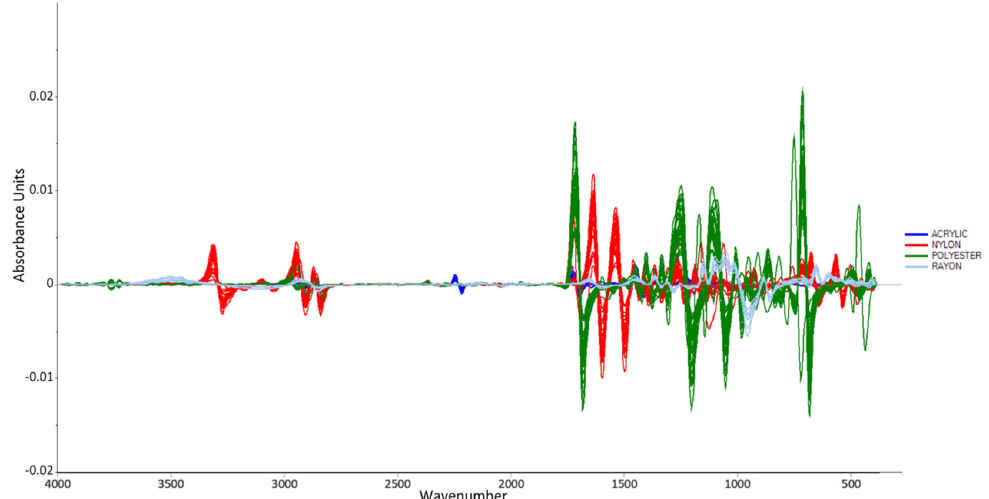
Figure 3. Calibration plot after performing Savitzky-Golay first derivative preprocessing technique.